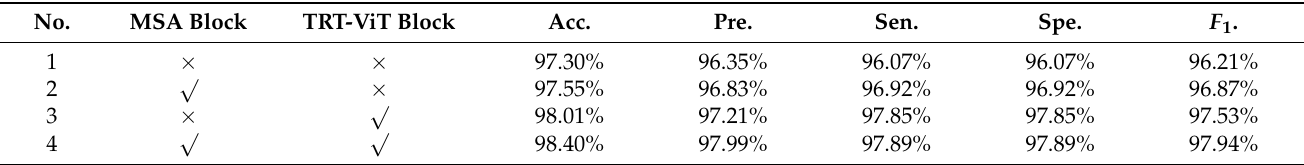
Table 10. Results of the ablation experiment on the Coronahack